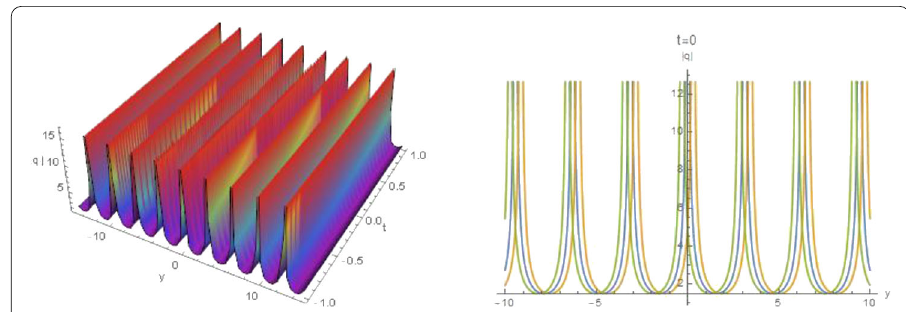
Figure 2 Graphs of the solitary wave for (3.36) with m → 0, a = 1, c = 0.1, k = 1